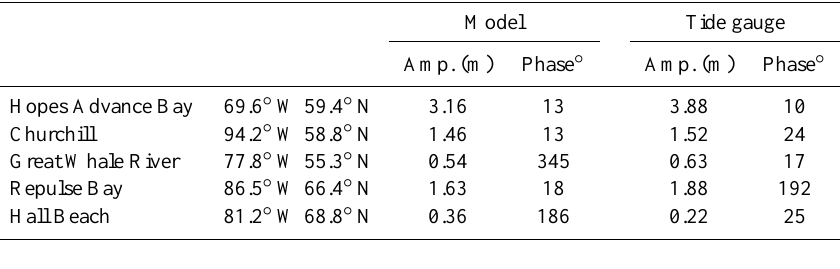
Table 1. Model M2 tidal amplitude (m) and phases (degrees relative to the equilibrium tide at Greenwich) compared with tide gauge analyses (IHB, 1954).